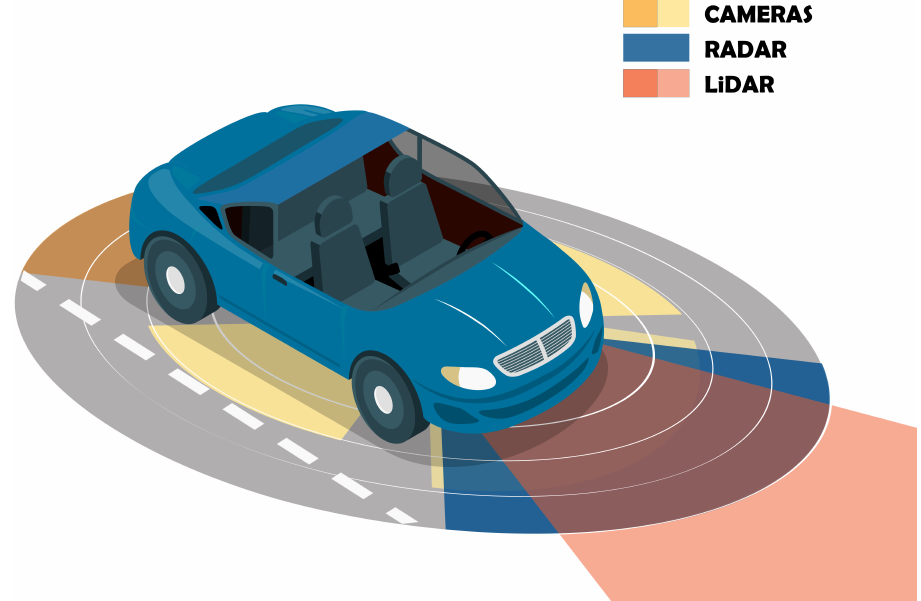
Figure 1. Multi-sensor perception